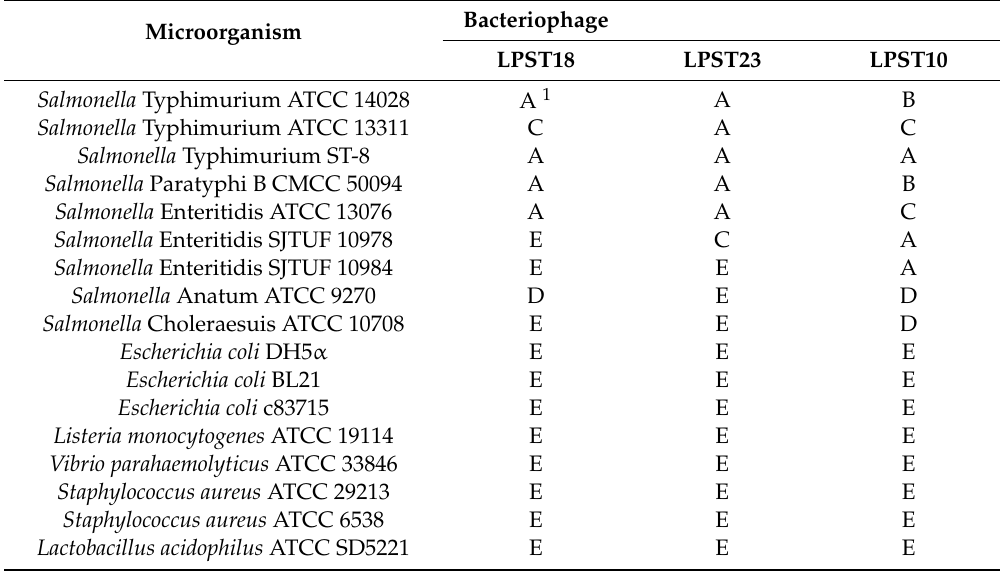
Table 2. E ffi cacy of phages against Salmonella strains and other pathogens. Microorganism